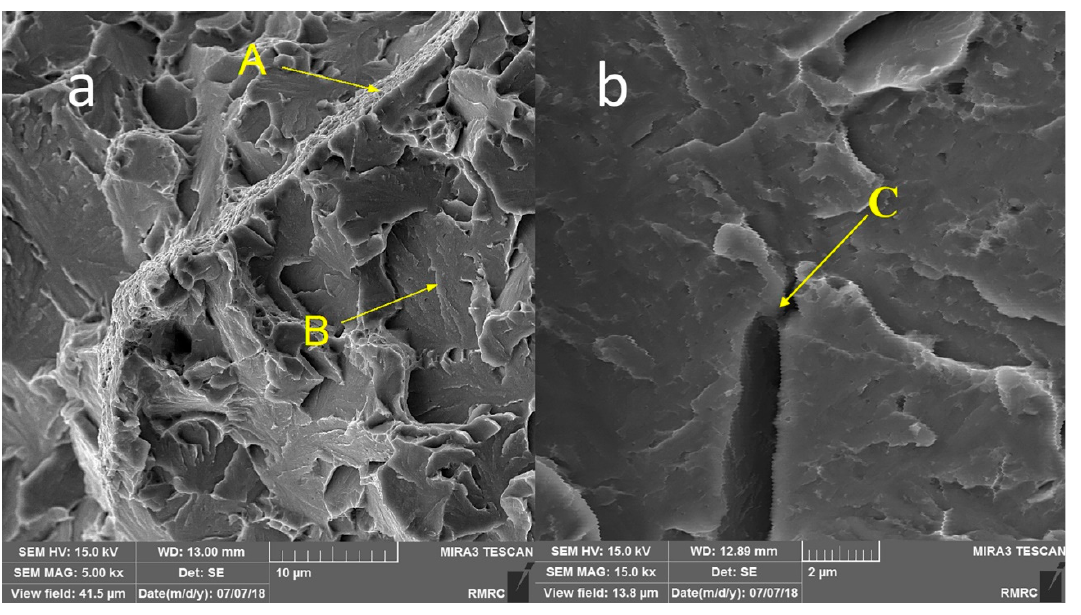
Figure 13. SEM images of the fracture surfaces of 1.6511Si2 after impact testing ( a ) two different fracture surfaces, a ductile fracture (dimples in A area) and brittle crack face (B area); and ( b ) crack blunting by the second phase (C area).